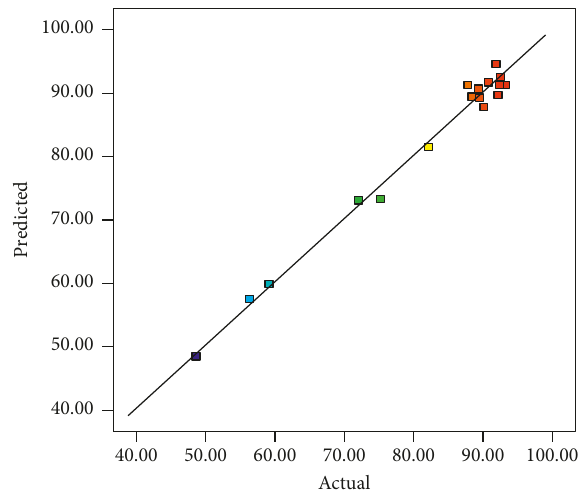
Figure 1: Plot of the actual (experimental) versus model predicted biodiesel yield (%).